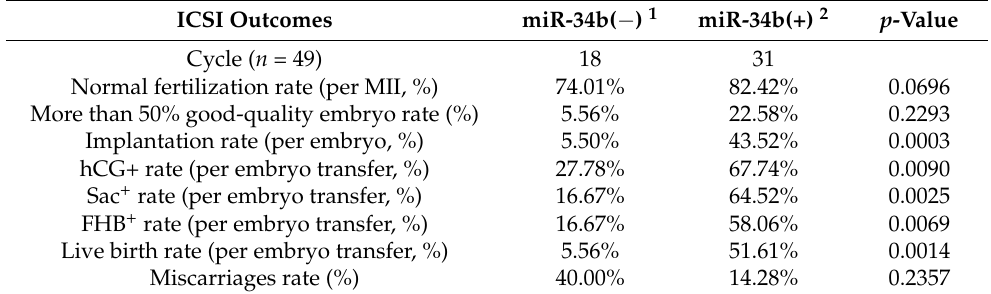
Table 2. Comparison of sperm miR-34b levels and ICSI outcomes in men with teratozoospermia.